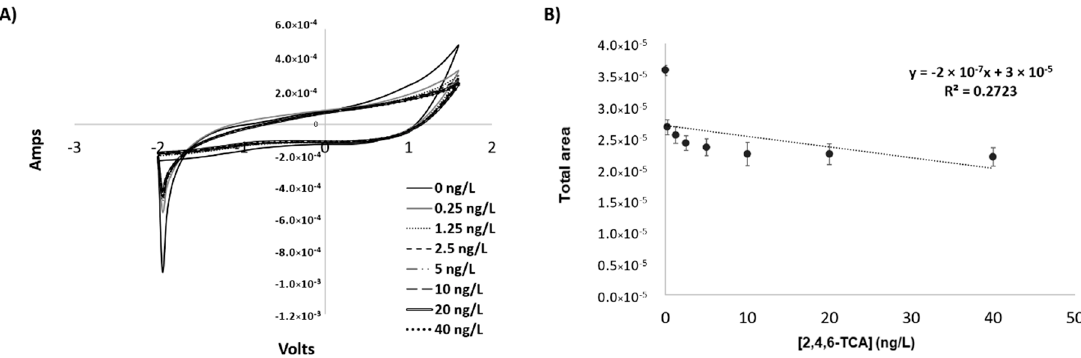
Figure 10. Cyclic voltammogram for ACN/H 2 O mixtures (3:2 ( v / v ) with 0.1 M of TBAP) without (0 ng/L, black line) and with 2,4,6-TCA addition (0.25 to 40 ng/L) ( A ), Schematic representation of the calibration curve obtained for different 2,4,6-TCA concentrations in ACN/H 2 O mixtures (3:2 ( v / v ) with 0.1 M of TBAP) ( B ).